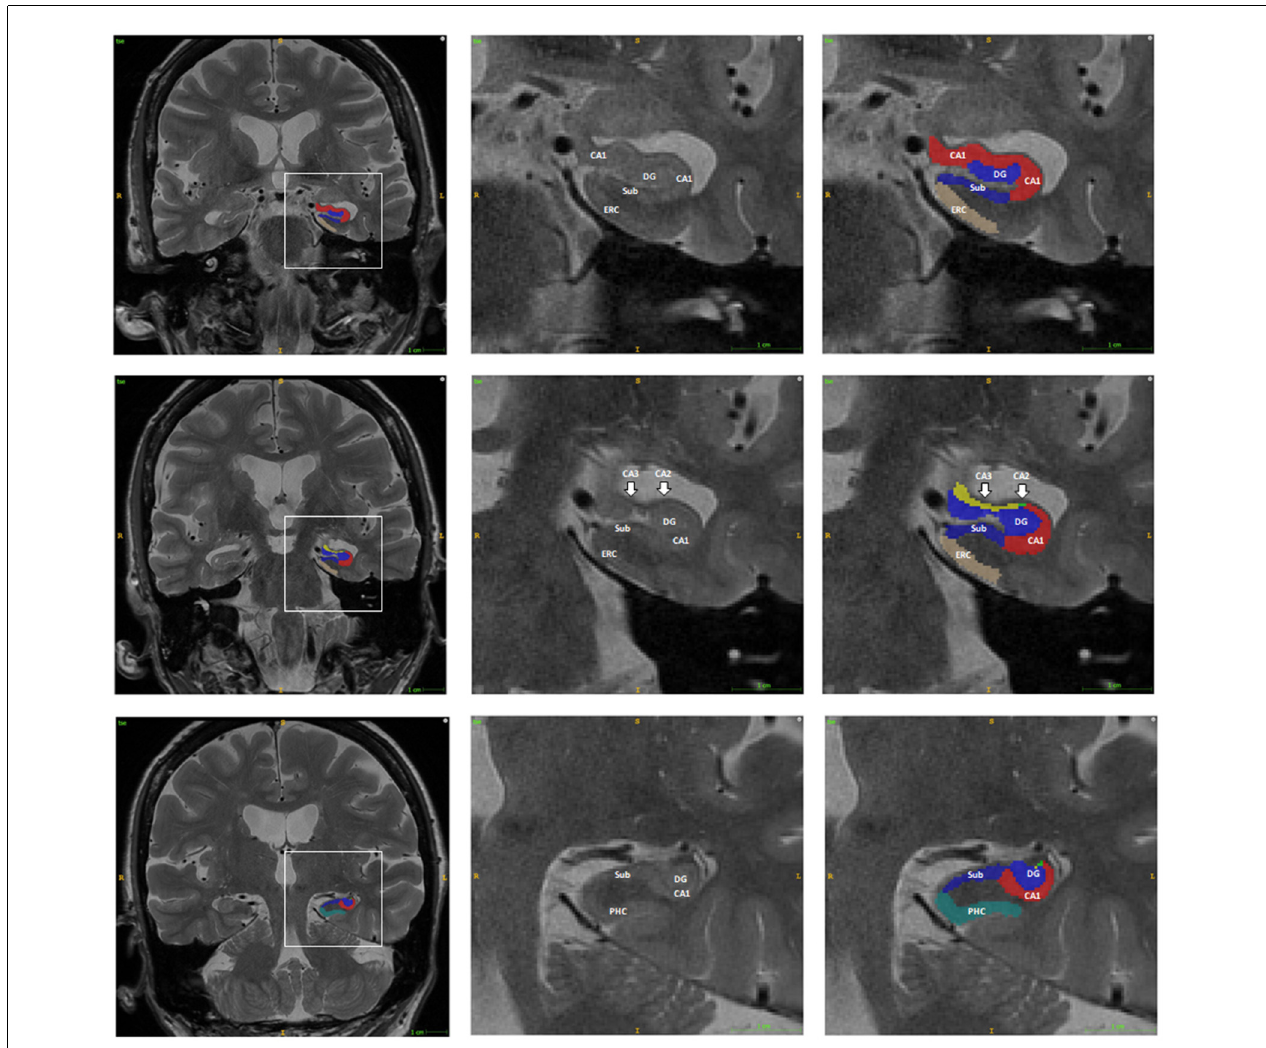
FIGURE 1 | Example of the automatic segmentation of the hippocampal subfield using ASHS software. The boundary of each hippocampal subfield of the hippocampal head (first row), body (second row), and tail (third row) are shown using ITK-SNAP software. The right two columns are the enlargement of the box in the left column. Abbreviations: DG, dentate gyrus; CA, Cornu Ammonis; Sub, subiculum; PHC, para-hippocampus; ERC, entorhinal